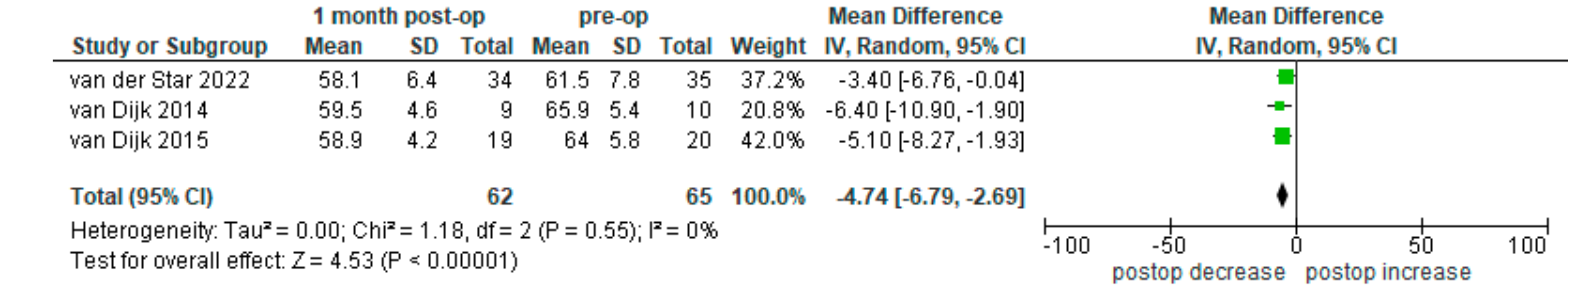
Figure A6. Di ff erence in mean simulated keratometry across 3 studies [27,31,43]. Figure A6. Difference in mean simulated keratometry across 3 studies [27,31,43].